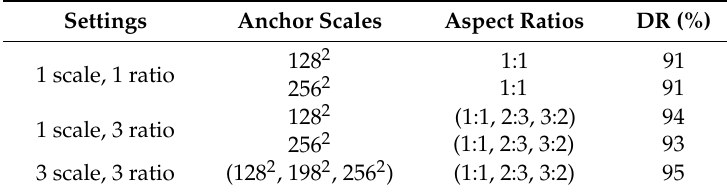
Table 4. Detection results using different settings of